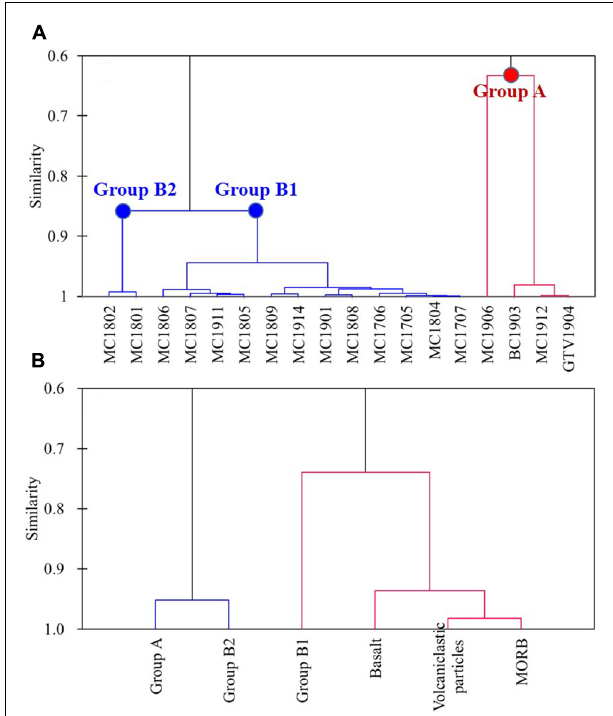
FIGURE 2 | Dendrograms showing the results of agglomerative hierarchical clustering for (A) the sediment sampling stations and (B) the sediment groups of the study area and end-members (volcaniclastic particles, basalt, and MORB) using the Pearson’s correlation coefficient method. MORB, mid-ocean ridge